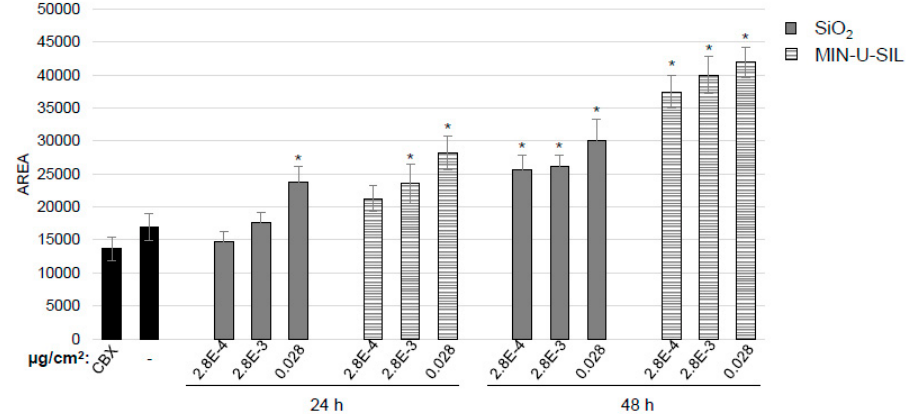
Figure 5. Astrocytoma cells were grown on coverslips and exposed to dispersion media alone as a control or to the indicated doses of dispersed dust for 24 and 48 h. Carbenoxolone (CBX) was included in one well for each experiment as a control for dye uptake solely by the cut in the cell layer. After this time scrape loading was performed using Lucifer Yellow. Confocal microscopy was used to detect fluorescence and the levels of gap junctional intercellular communication were determined by means of the area of dye-coupled cells. Quantification of three independent experiments is shown. Bars: SE. * p < 0.05 indicates a significant difference between exposed cells and the corresponding sham-treated control. Error bars: SE.